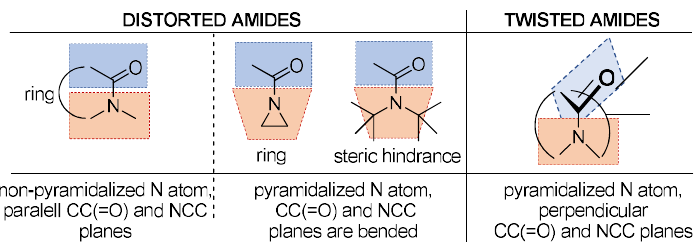
Figure 9. Redefined difference between the distorted and twisted amides. Distorted amides suffer steric hindrance or ring stress with pyramidalized or non-pyramidalized N atom. Twisted amides do not exhibit any strain, with perpendicular, non-overlapping amide planes. The carbonyl and amide planes are illustrated by the parallel- or perpendicularly-oriented blue and orange colors.